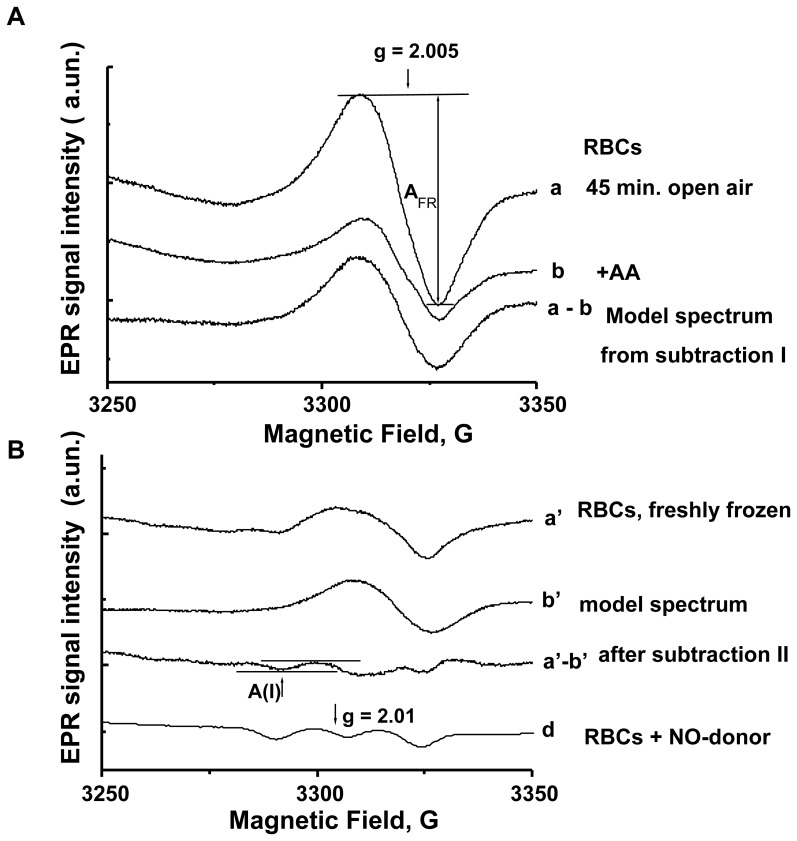
Measurements of HbNO in human RBCs by a modified EPR subtraction procedure.(A) Typical EPR spectra of free radicals in RBCs left for 45 min. in open air at room temperature: the individual model spectrum of free radicals in RBCs (lowest spectrum, a–b) was obtained after subtraction (subtraction I) of the EPR spectrum of RBCs treated with ascorbic acid (AA, 10 mmol/L, for the last 15 minutes) (b), from the EPR spectrum of RBC treated similarly with solvent (a). (B) Measurements of HbNO level in RBCs isolated from venous blood by EPR spectroscopy using subtraction (subtraction II) of individual free radical signal. The high field components of the EPR spectrum of RBCs frozen immediately after sampling (upper spectrum, a′) are shown at diapason 3250–3350 Gauss. The final EPR spectrum (a′–b′) shows the hf components of gz HbNO signal after subtraction of the model EPR spectrum of free radicals (b′), divided by the correspondent proportional scale factor (gain = 6.23×104); a typical EPR spectrum of RBCs, frozen after incubation with NO-donor (Dea-NONOate, 50 µmol/L) under low O2 level (gain = 0.62×104) is shown for comparison (d). The peak-to-peak amplitude of the 1st hf component (A(I)) of the triplet hf structure of the EPR spectrum, attributed to 5-coordinate α-HbNO, was used for quantitation.